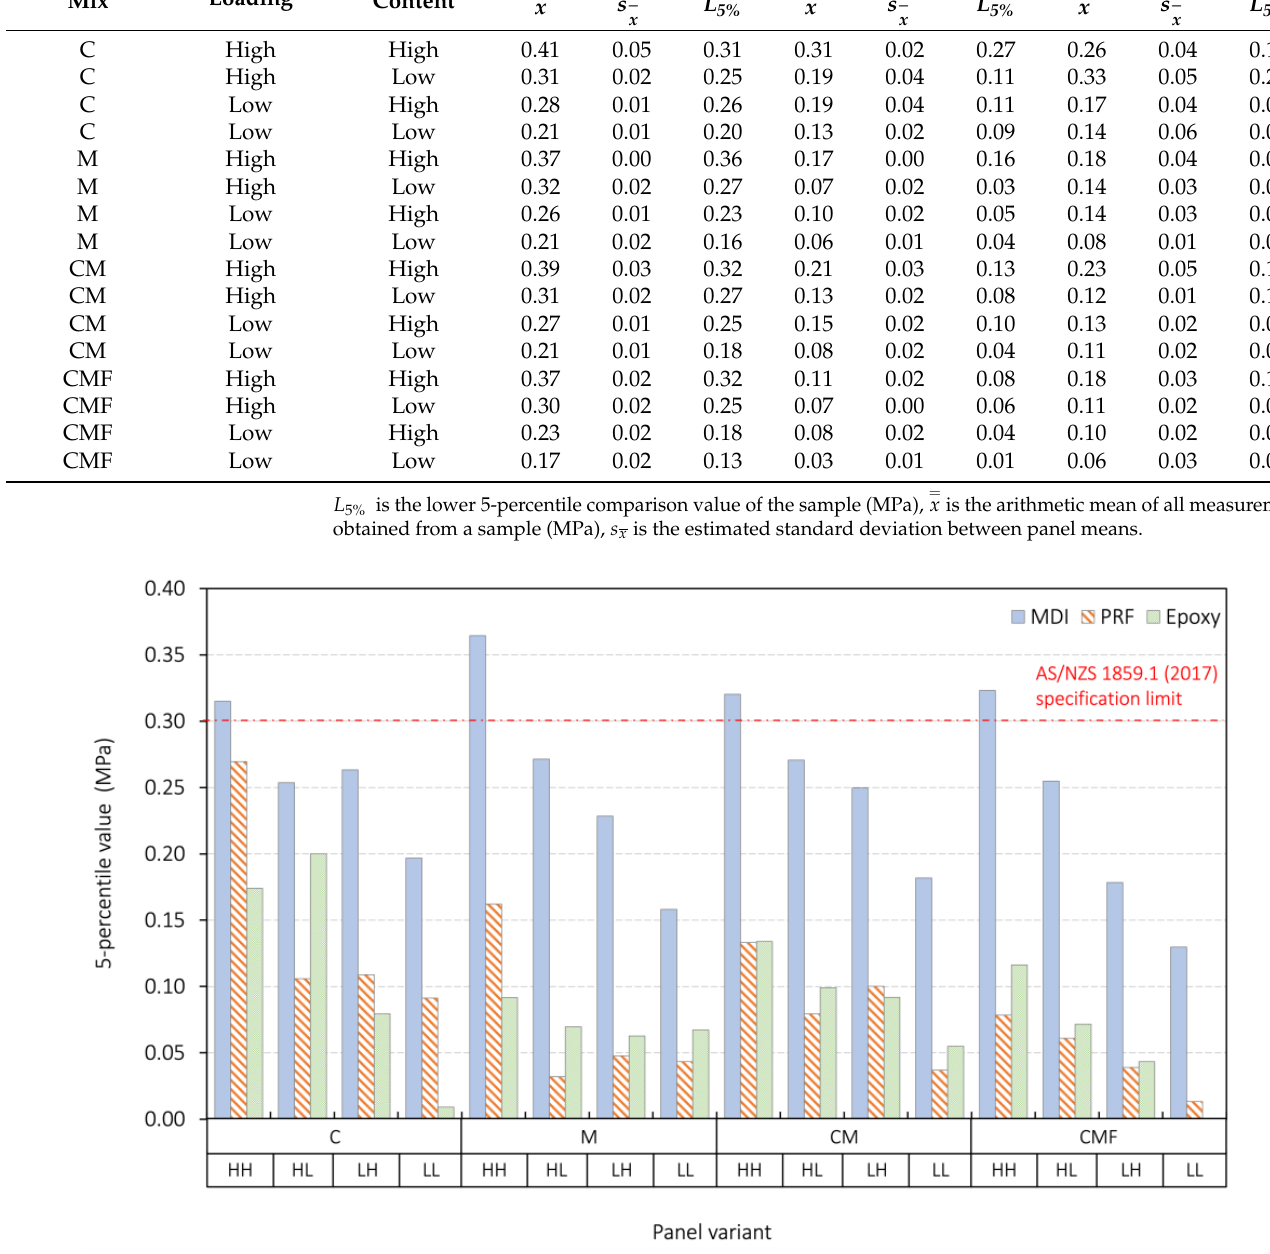
Table 9. IB results and corresponding 5-percentile comparison values of MDI, PRF and epoxy ULHPB.